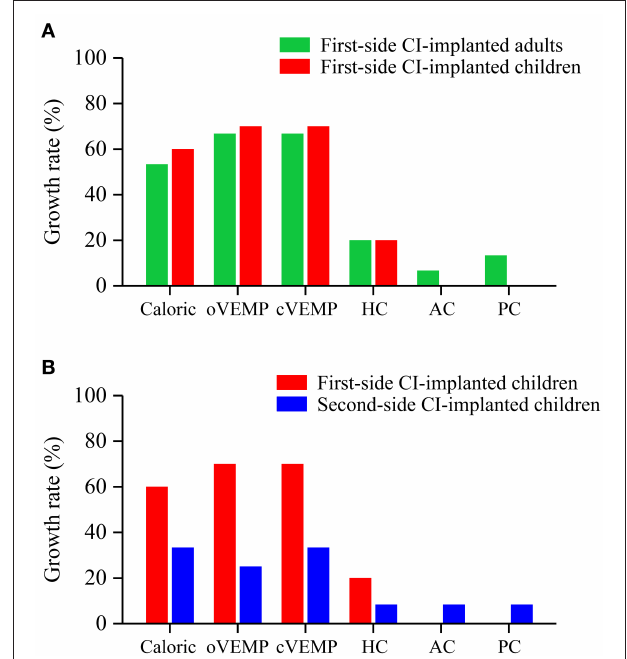
FIGURE 3 | Growth rates of abnormal vestibular functions revealed by the caloric test, VEMP test and vHIT. No significant difference of growth rates was found (A) between first-side CI-implanted adults and children or (B) between first- and second-side CI-implanted children.